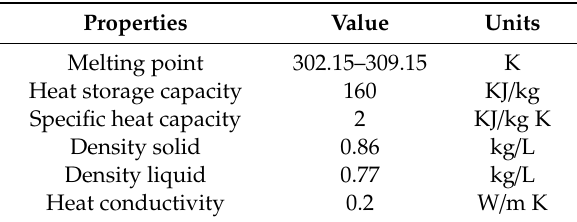
Table 4. PCM thermal